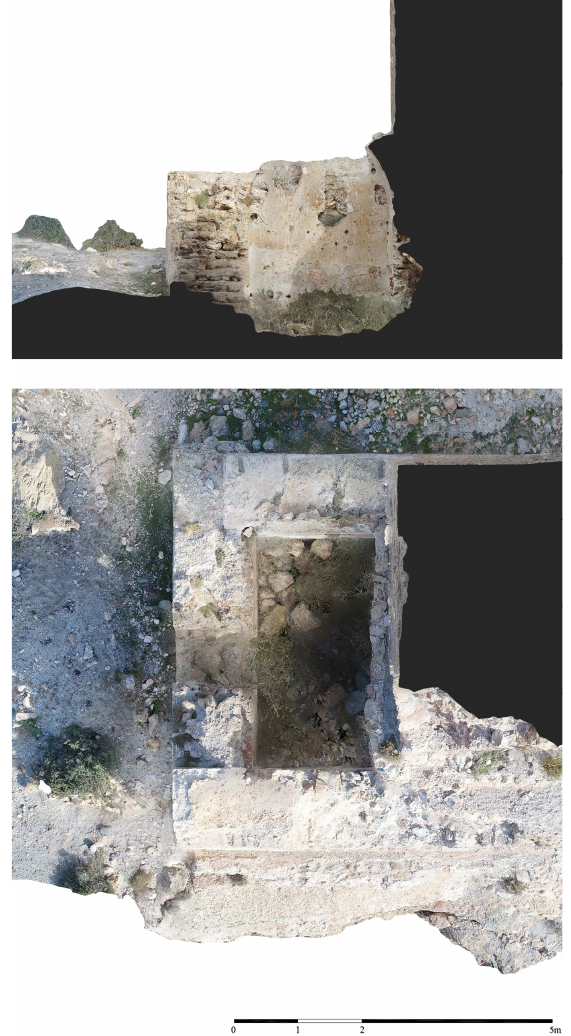
Figure 7. Cistern of the fortress of Dúrcal. Mesh and inside axonometric